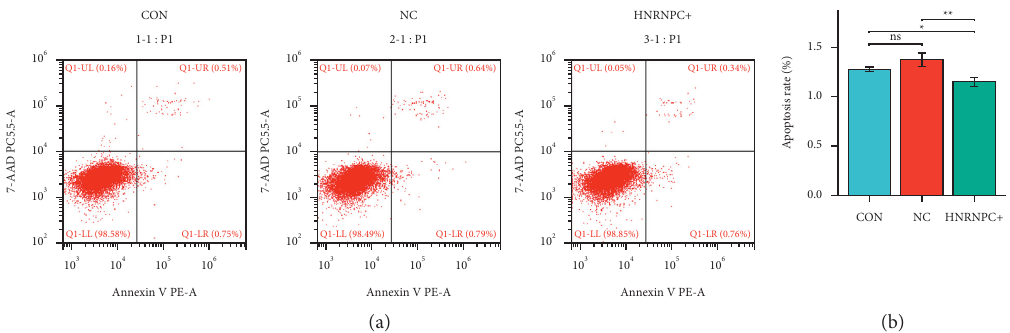
Figure 6: The effect of overexpression of HNRNPC on PC12 cell apoptosis. CON: control group, NC: empty plasmid group, HNRNPC+: overexpression HNRNPC group.